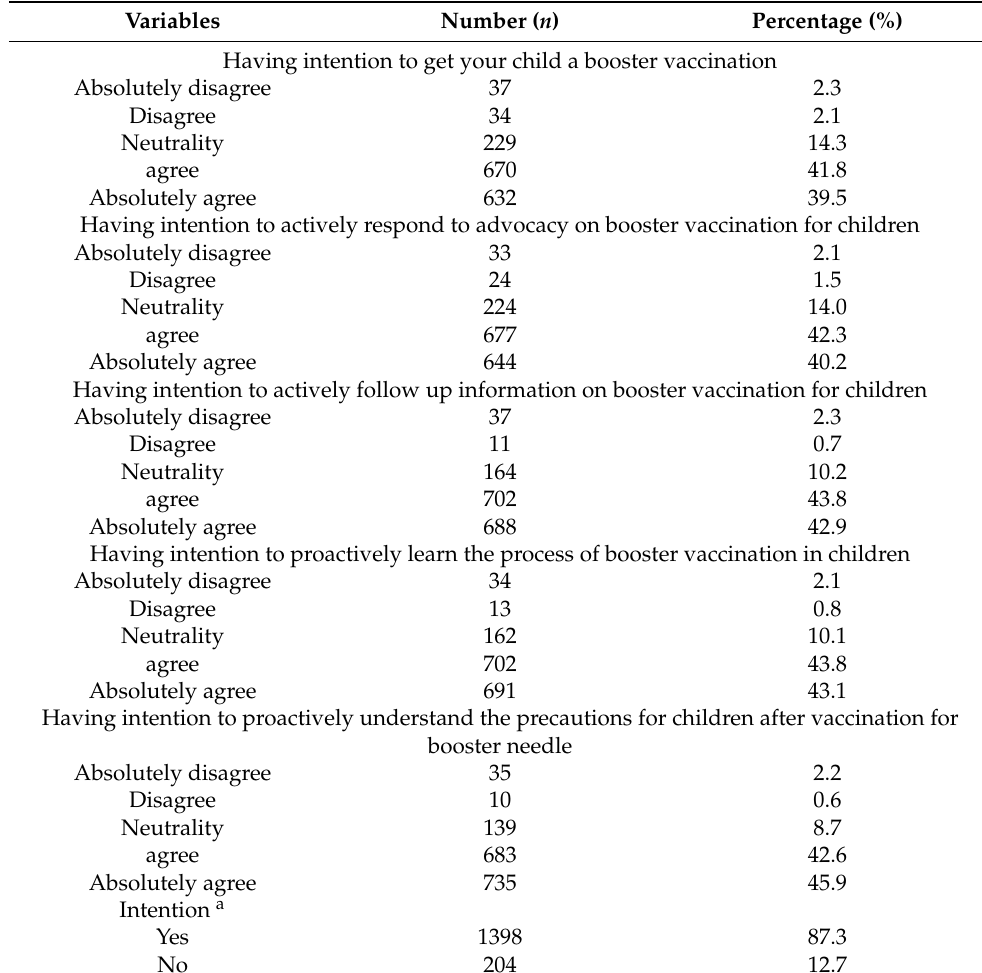
Table 3. Parents’ intention on COVID-19 booster vaccination in children ( n =